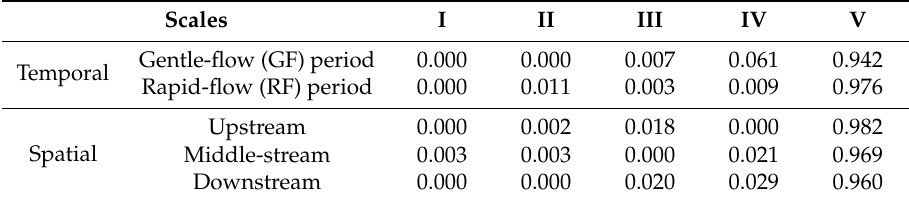
Table 2. Integrated evaluation form of water